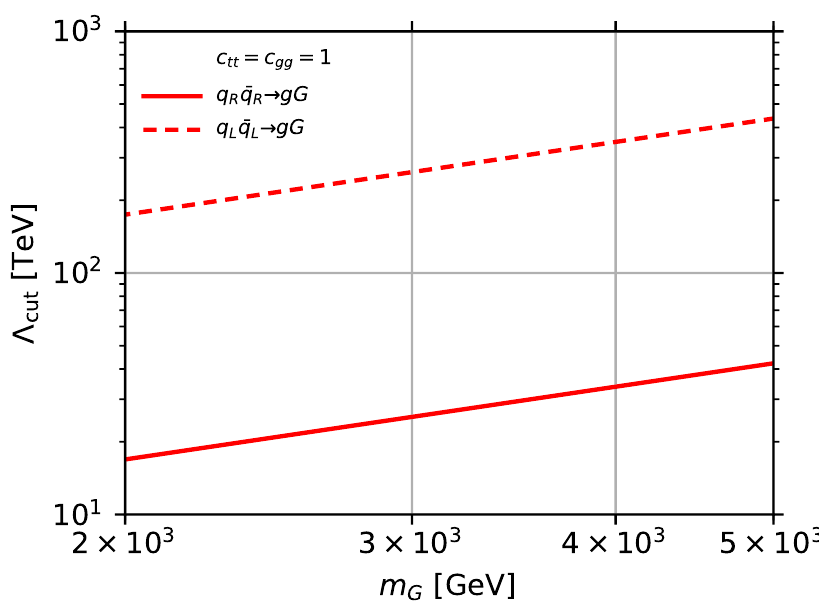
Figure 7 . The cuto(cid:11) scale (cid:3) cut as a function of the KK graviton mass with the region bellow each line